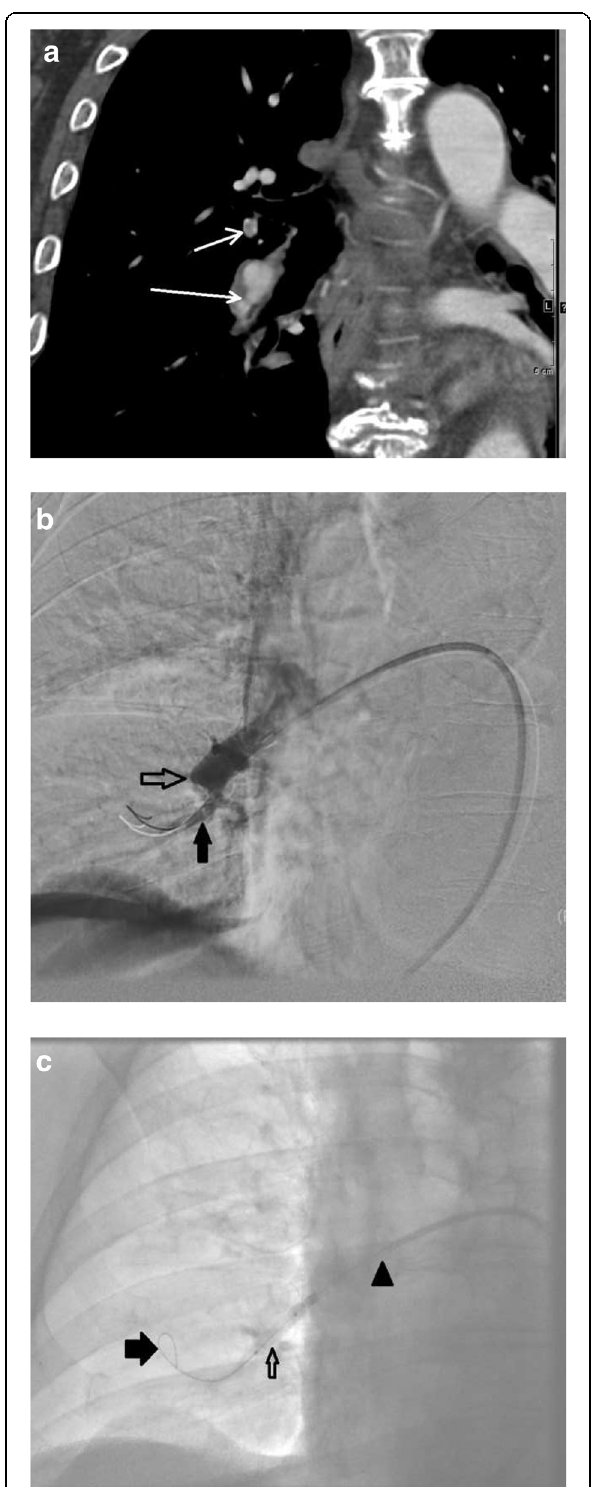
Fig. 24 Imaging and treatment in a patient with CTEPH. An 82-year- old male patient, nonsurgical candidate, with central-type and distal- type CTEPH. a CTA demonstrating webs and bands (white arrows). b Region of stenosis (solid black arrow) and occlusion (open black arrow) due to webs and bands. c Fluoroscopic image of balloon pulmonary angioplasty. A 4 mm balloon (open black arrow), passed through a 7 Fr 90 cm Brite Tip sheath (Cordis, Milpitas, CA, USA, arrow head), over a V18 (Boston Scientific, Malborough, MA) working wire (solid black arrow). d Pulmonary angiogram demonstrates revascularized segmental pulmonary arteries (black